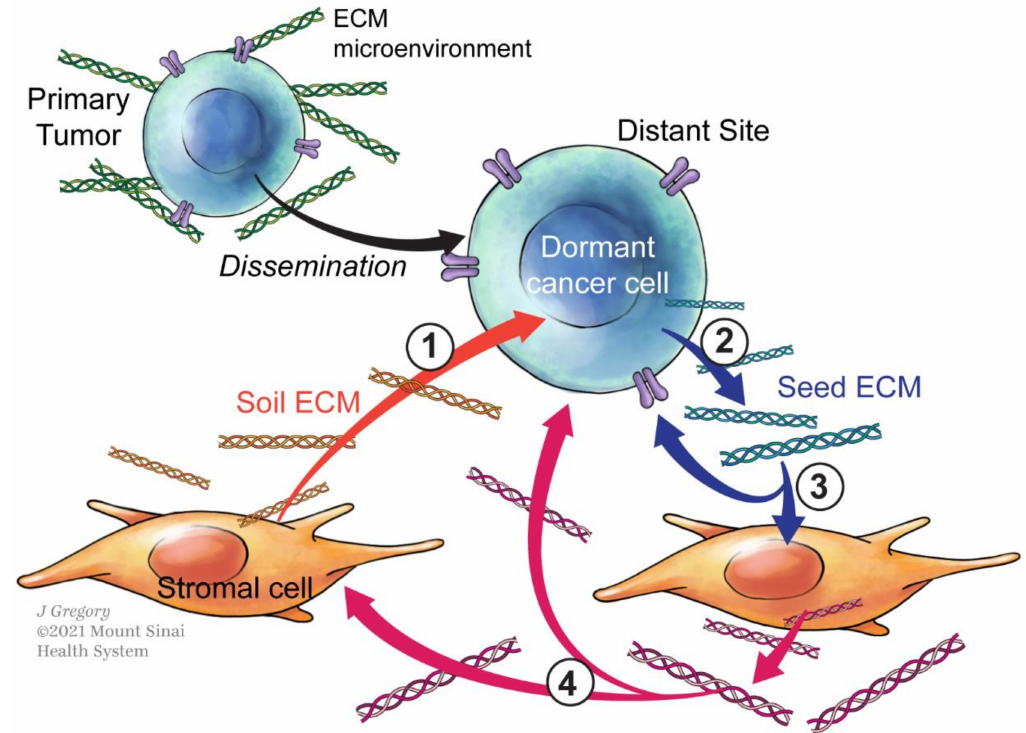
Figure 1. The seed at the center of Paget’s theory. Cancer cells (represented in blue) disseminate to a distant site. ( 1 ) The seed (cancer cells) will first sense and attach to the “Soil ECM” (represented in yellow). ( 2 ) The seed will also secrete the “Seed ECM” (blue). ( 3 ) In the context of dormancy, this “seed ECM” will sustain the dormant state of the seed itself and influence the stromal cells to adapt their ECM production (red). ( 4 ) This ECM produced by stromal cell (red) in response to the dormant cells will then be able to signal back to the stroma itself and to the